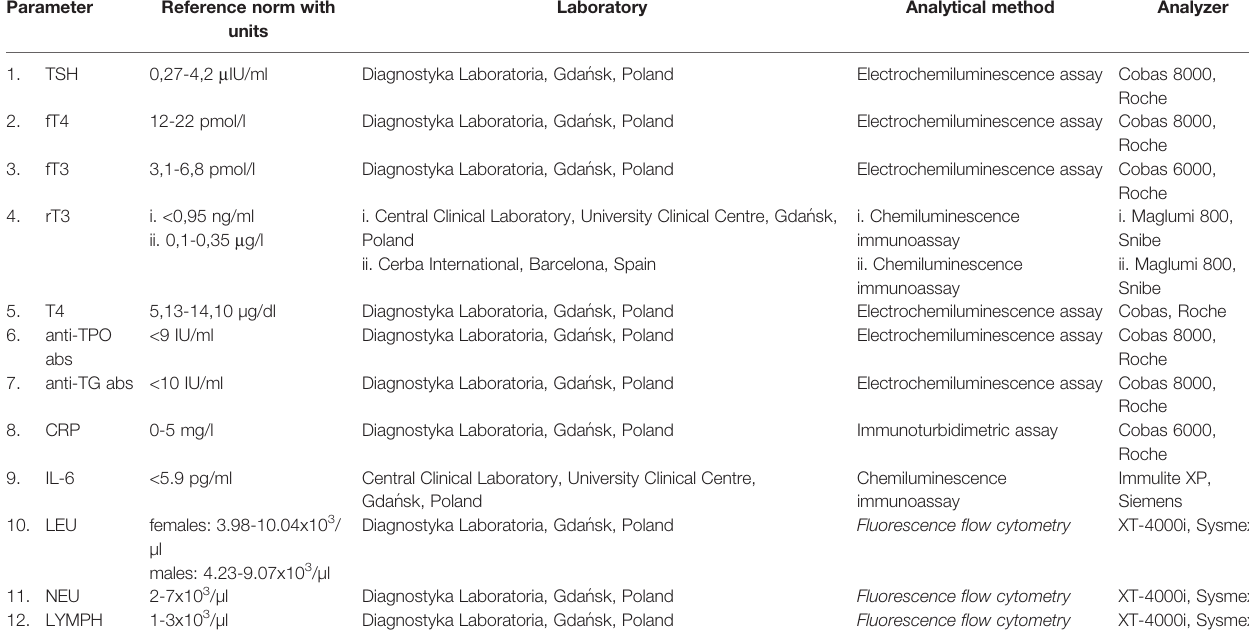
TABLE 1 | Detailed technical information on used laboratory